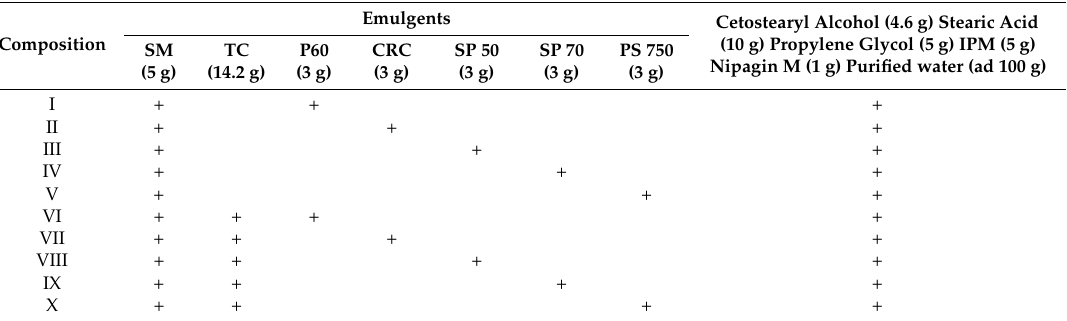
Table 1. The composition of the silymarin